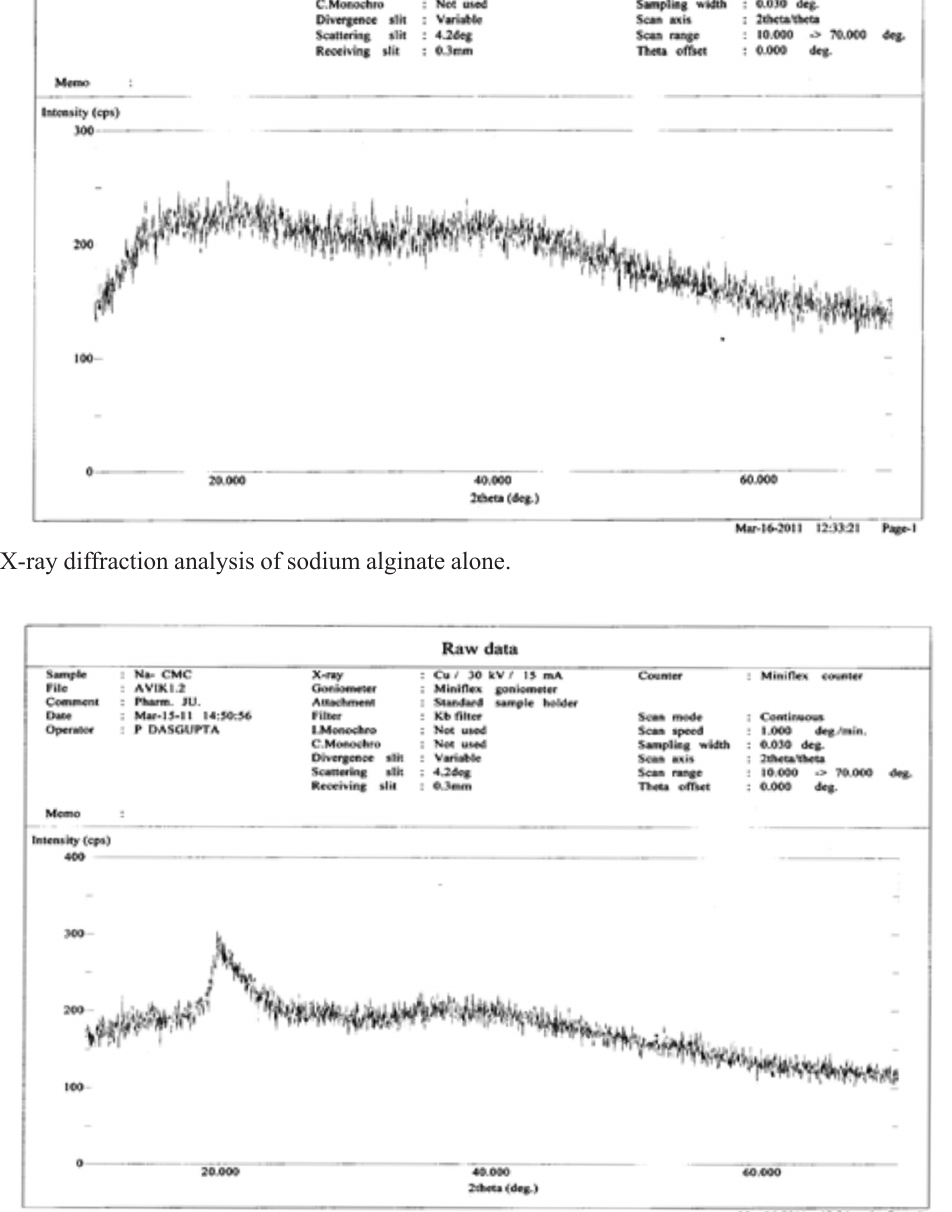
FIGURE 9 (c) - X-ray diffraction analysis of sodium carboxymethyl